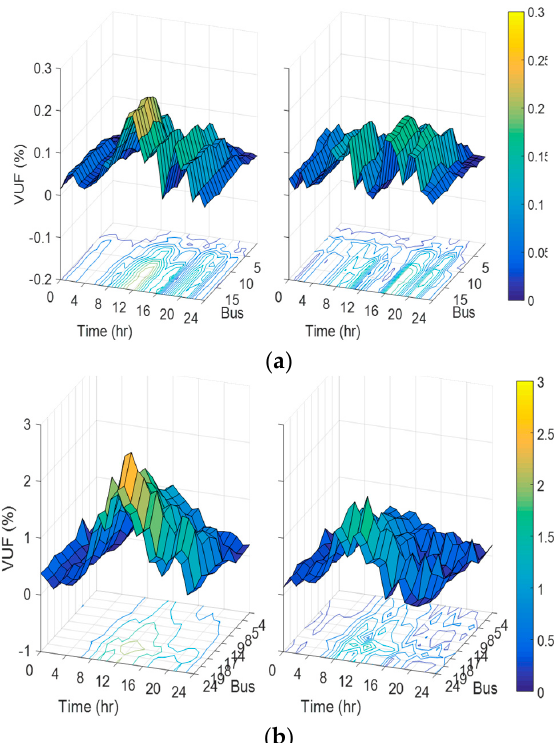
Figure 9. Voltage unbalance profile before and after the proposed control: ( a ) MV feeder; ( b ) LV feeder.